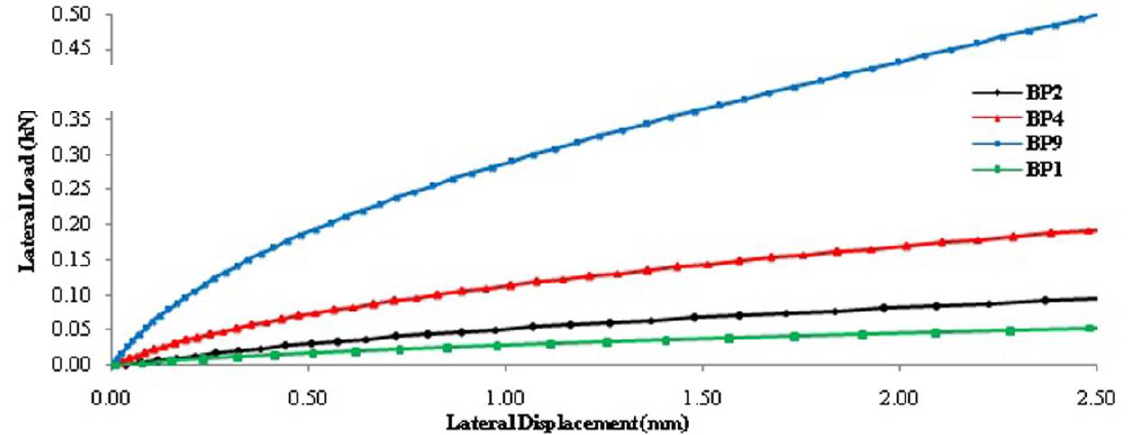
Fig. 6. Comparison between single pile and pile group lateral load results of bamboo pipe piles at 3D pile spacing in loose layer in-between dense layers and dense sand layer for slenderness ratio as